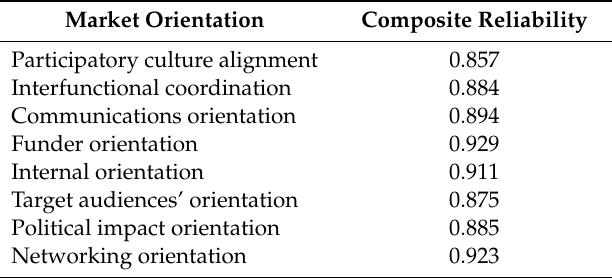
Table 5. Composite reliability of the first-order model.